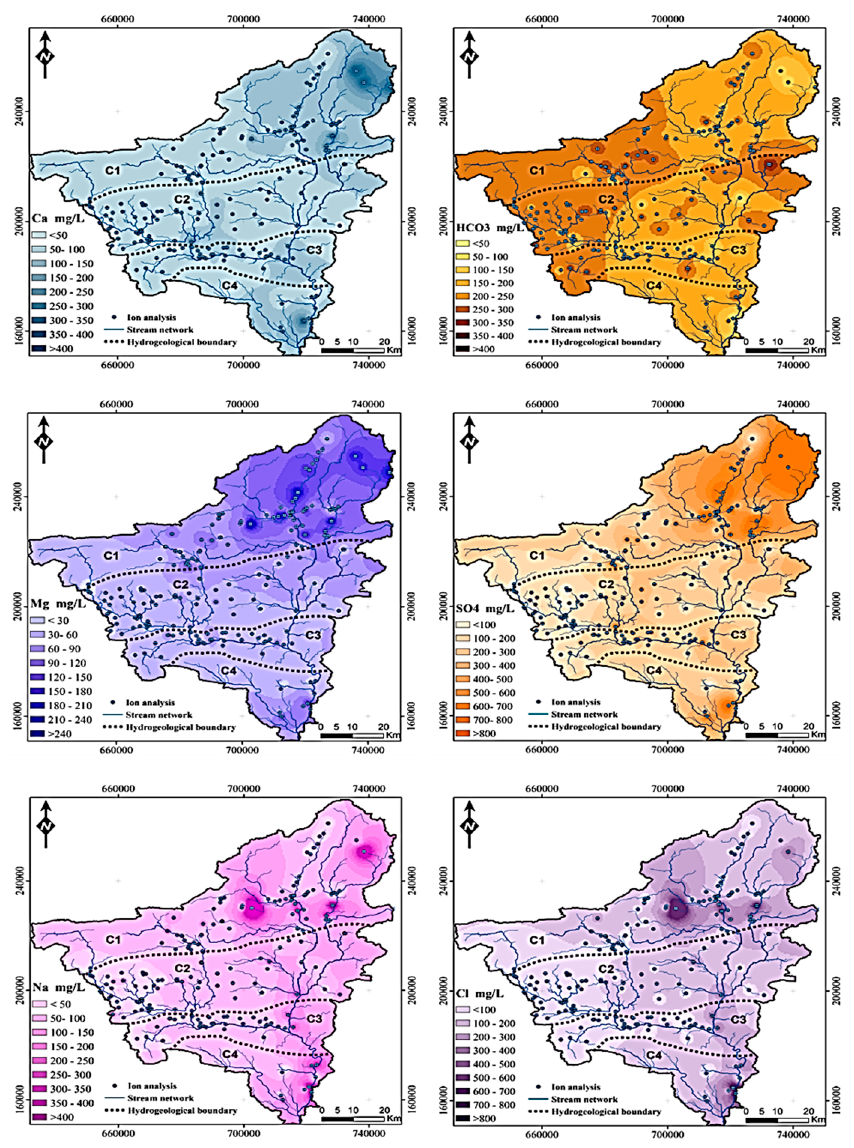
Figure 12. Distribution of major ion concentrations in the Eastern Upper Guir aquifer The HCO 3 − concentration gradient has the opposite orientation, with the highest values (300–350 mg/L) in the west and the lowest values (<50 mg L − 1 ) in the east. Nevertheless, in some places, close to the eastern border of the basin, high HCO 3 − is observed in relation to the reliefs of carbonate rocks